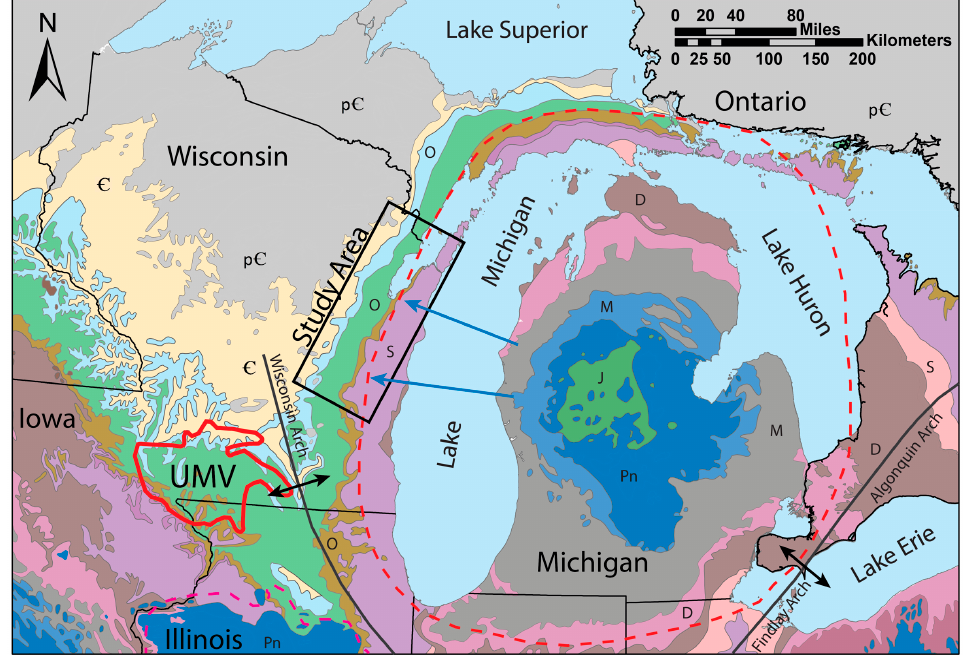
Figure 1. Bedrock geologic map of the western Great Lakes region of North America showing the locations of major geologic structures near the states of Wisconsin and Michigan. Geologic rock systems are as follows: p Є = Precambrian, Є = Cambrian, O = Ordovician, S = Silurian, D = Devonian, M = Mississippian, Pn = Pennsylvanian, J = Jurassic. Red dashed lines denote the Illinois and Michigan structural basins. Black lines with double arrows indicate the positions of structural arches. “UMV” indicates the location of the Upper Mississippi Valley Lead-Zinc Ore District as defined by Heyl et al. [8]. Blue arrows indicate inferred flow paths of hydrothermal fluids originating in the Michigan basin. Base map modified after [12,13].